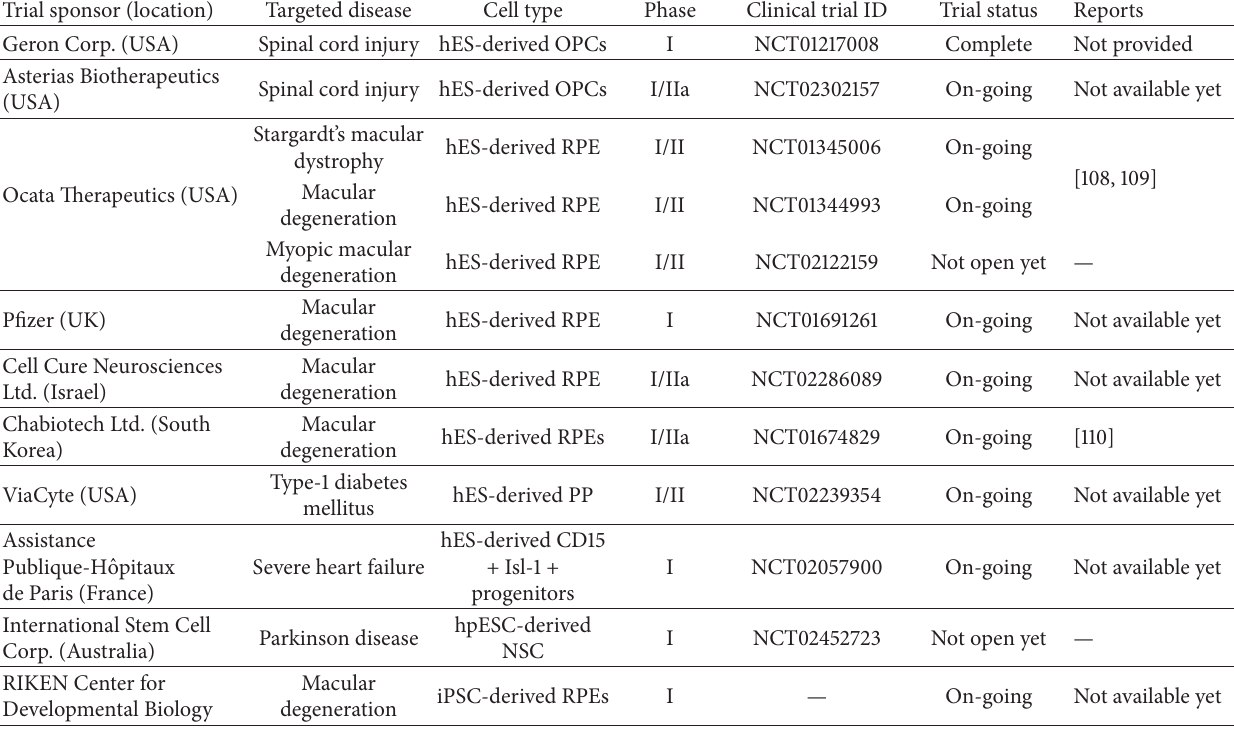
Table 1: Clinical trials using hESC- and hiPSC-derived products (modified by Trounson and McDonald